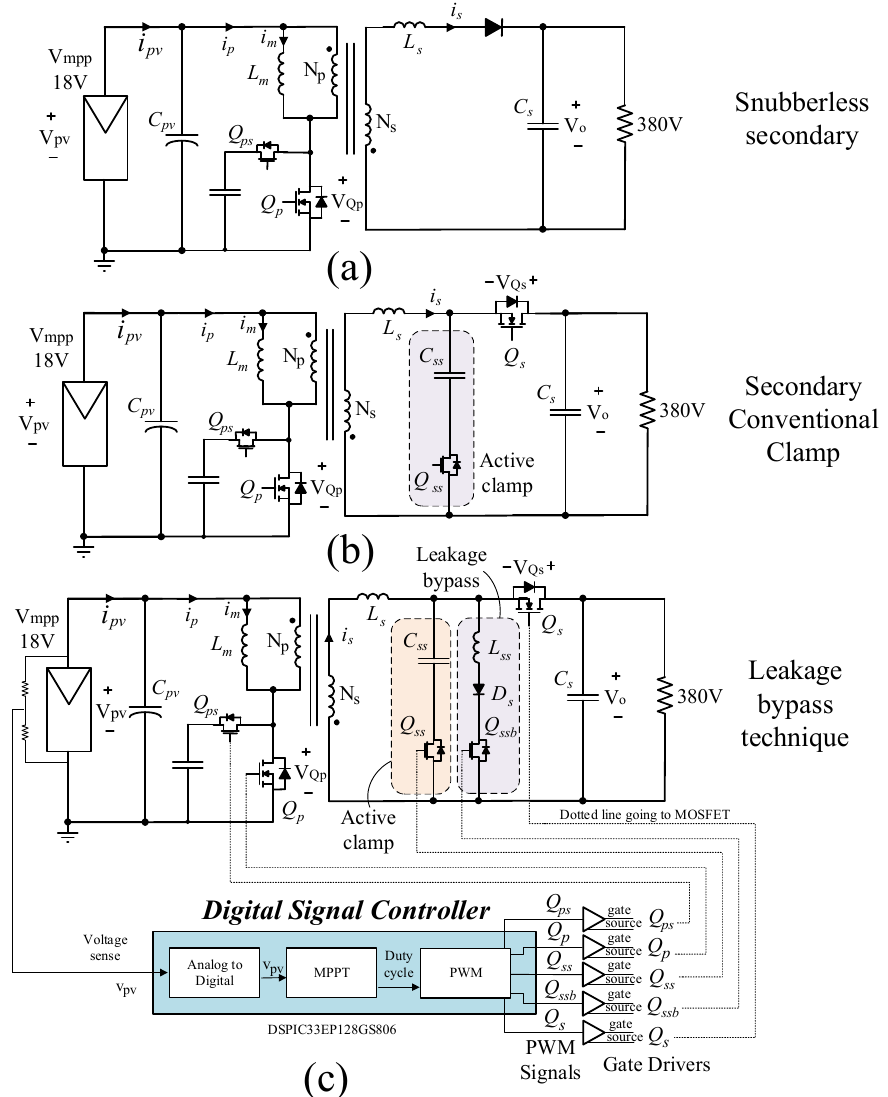
Figure 10. High step-up flyback under different secondary snubber configuration. ( a ) snubber less secondary (using 1.2 kV SiC Diode) ( b ) conventional secondary clamp (using 650 V GaN) ( c ) the proposed leakage bypass (using 650 V GaN).